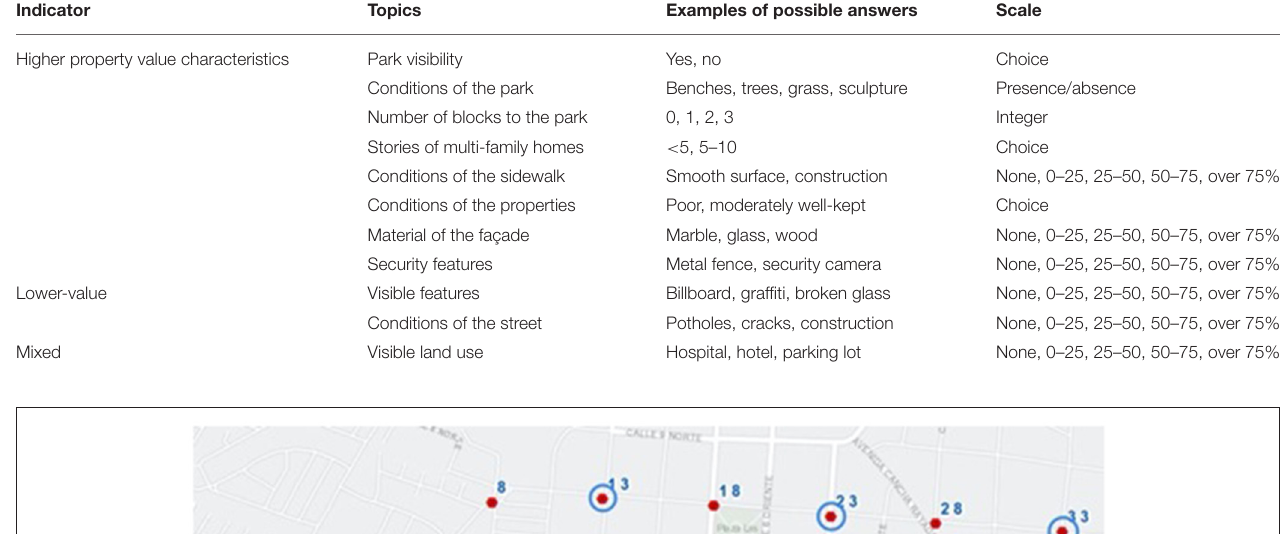
TABLE 2 | Topics of questions included in the survey. Indicator